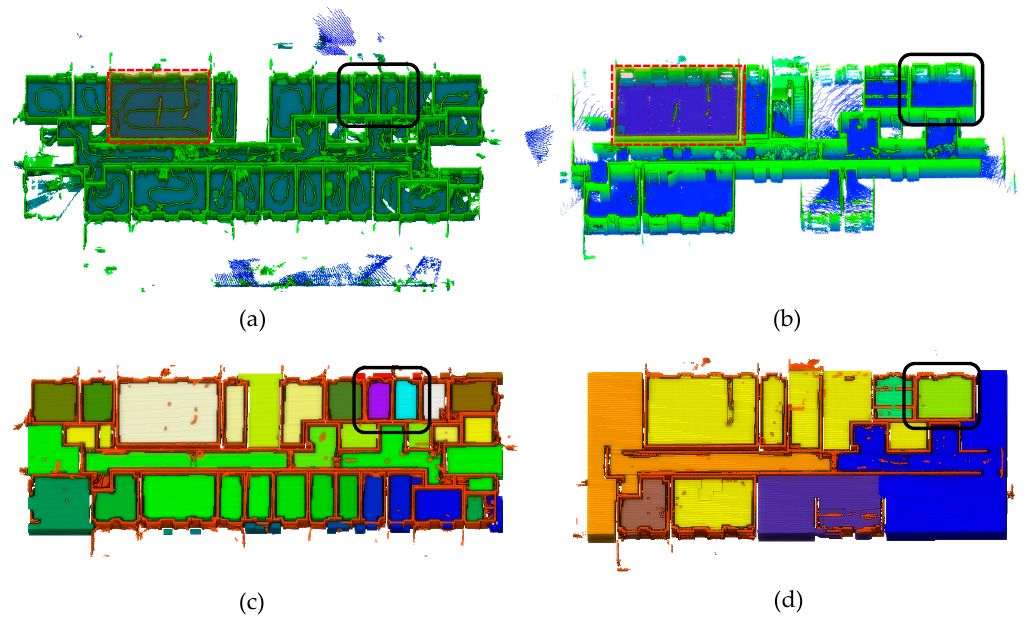
Figure 14. The figure represents the changes in the detected permanent structure and then the spaces. ( a ) and ( b ) show the changes in the walls (black rectangles). The red transparent rectangle is for the orientation between two images. ( c ) and ( d ) show the detected walls in orange and space partitions in random colors. The black rectangles show how the room changed after removing a wall.